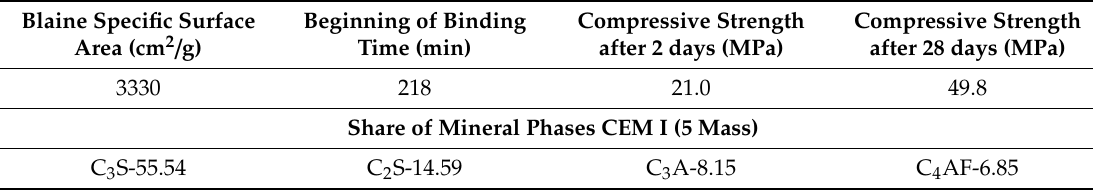
Table 2. Physical properties and phase composition of cement CEM I 42.5 R.